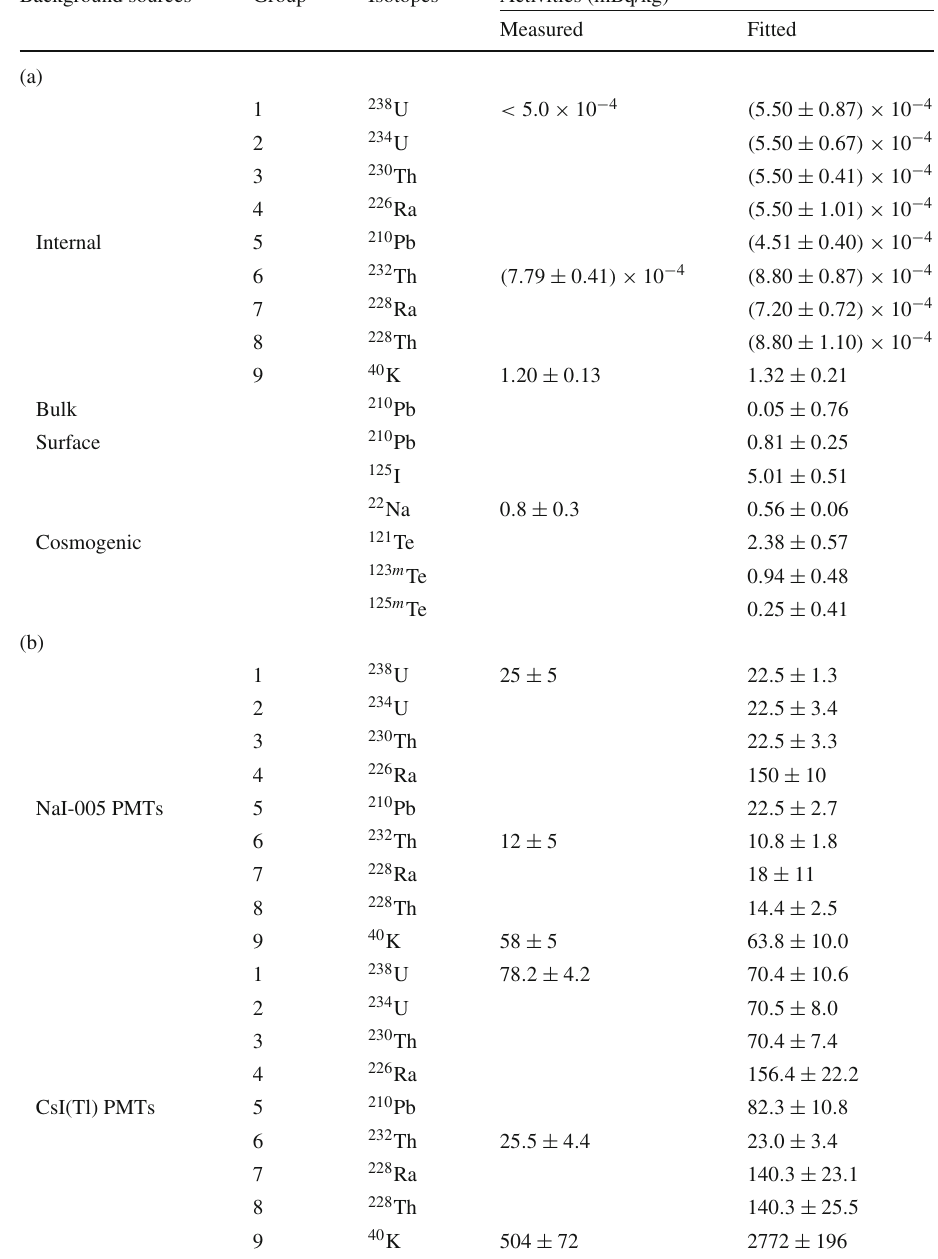
Table 4 Summary of the fitted radioactive contaminants in NaI-005 (a) and PMTs